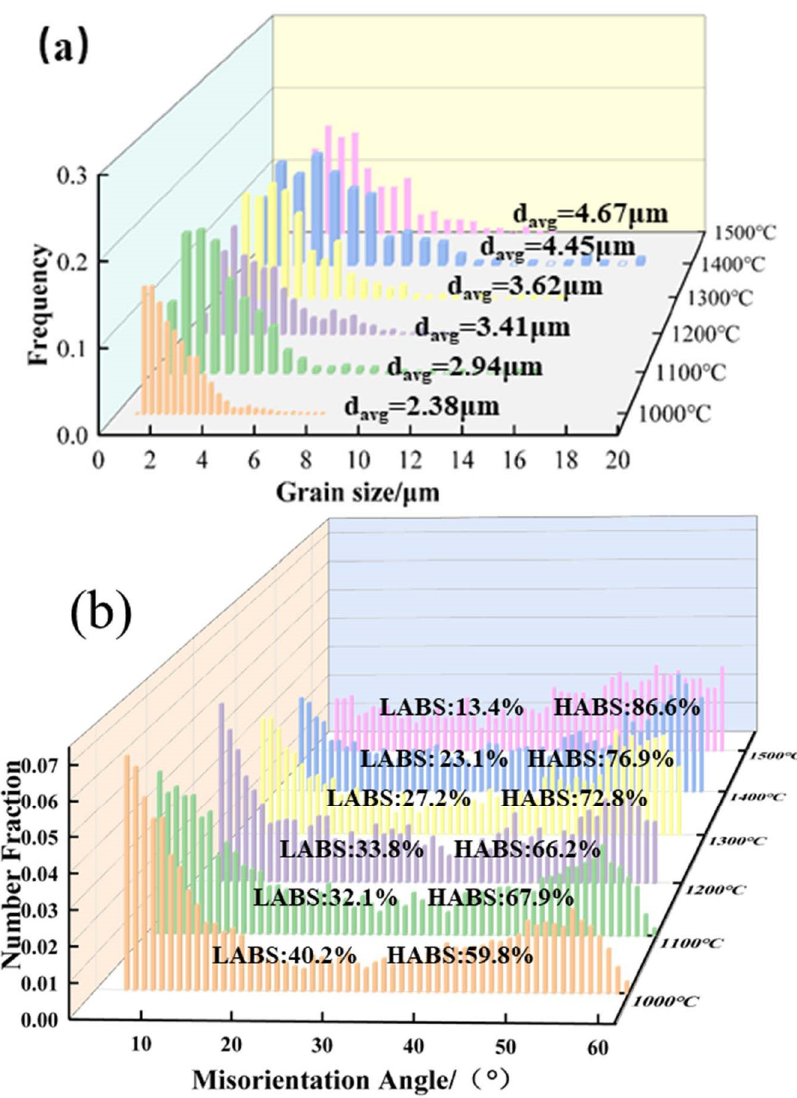
Figure 20. Mo–1.5wt% ZrO 2 Molybdenum alloy (0.01 s − 1 and 1000–1500 ◦ C): ( a ) Grain size distribu- Figure 20. Mo-1.5wt%ZrO 2 Molybdenum alloy (0.01 s -1 and 1000 ℃ -1500 ℃ ): (a) Grain size distri- 1 tion, ( b ) Grain boundary orientation difference bution, (b) Grain boundary orientation difference statistics.